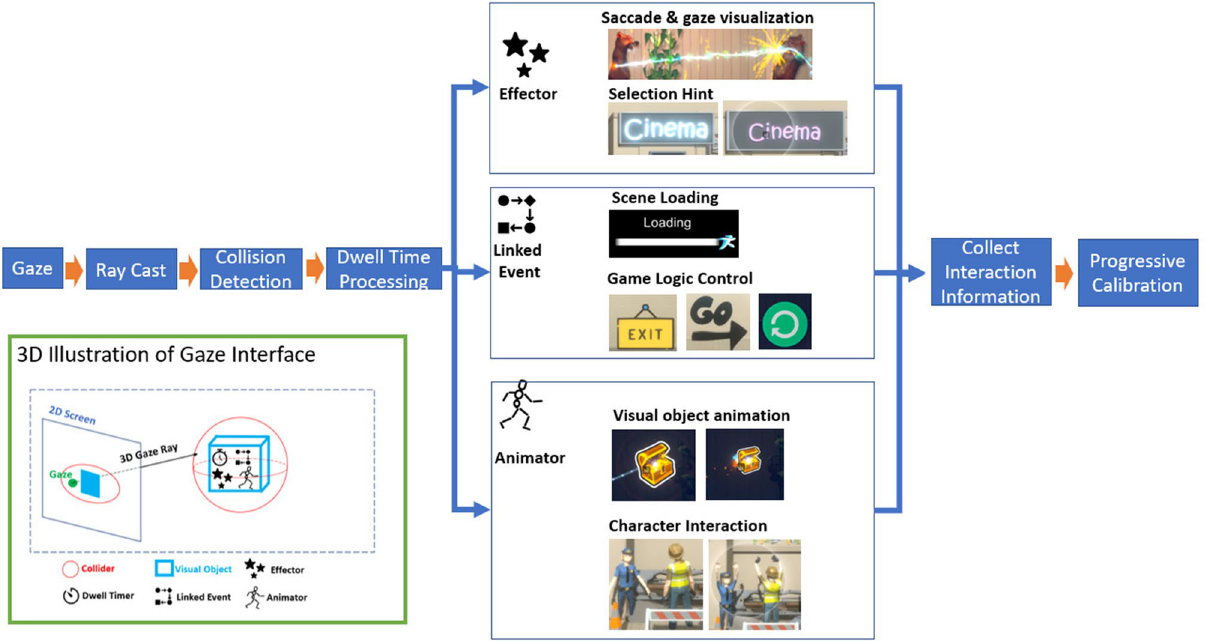
detection. Interaction in the virtual world is based on dwell time and target